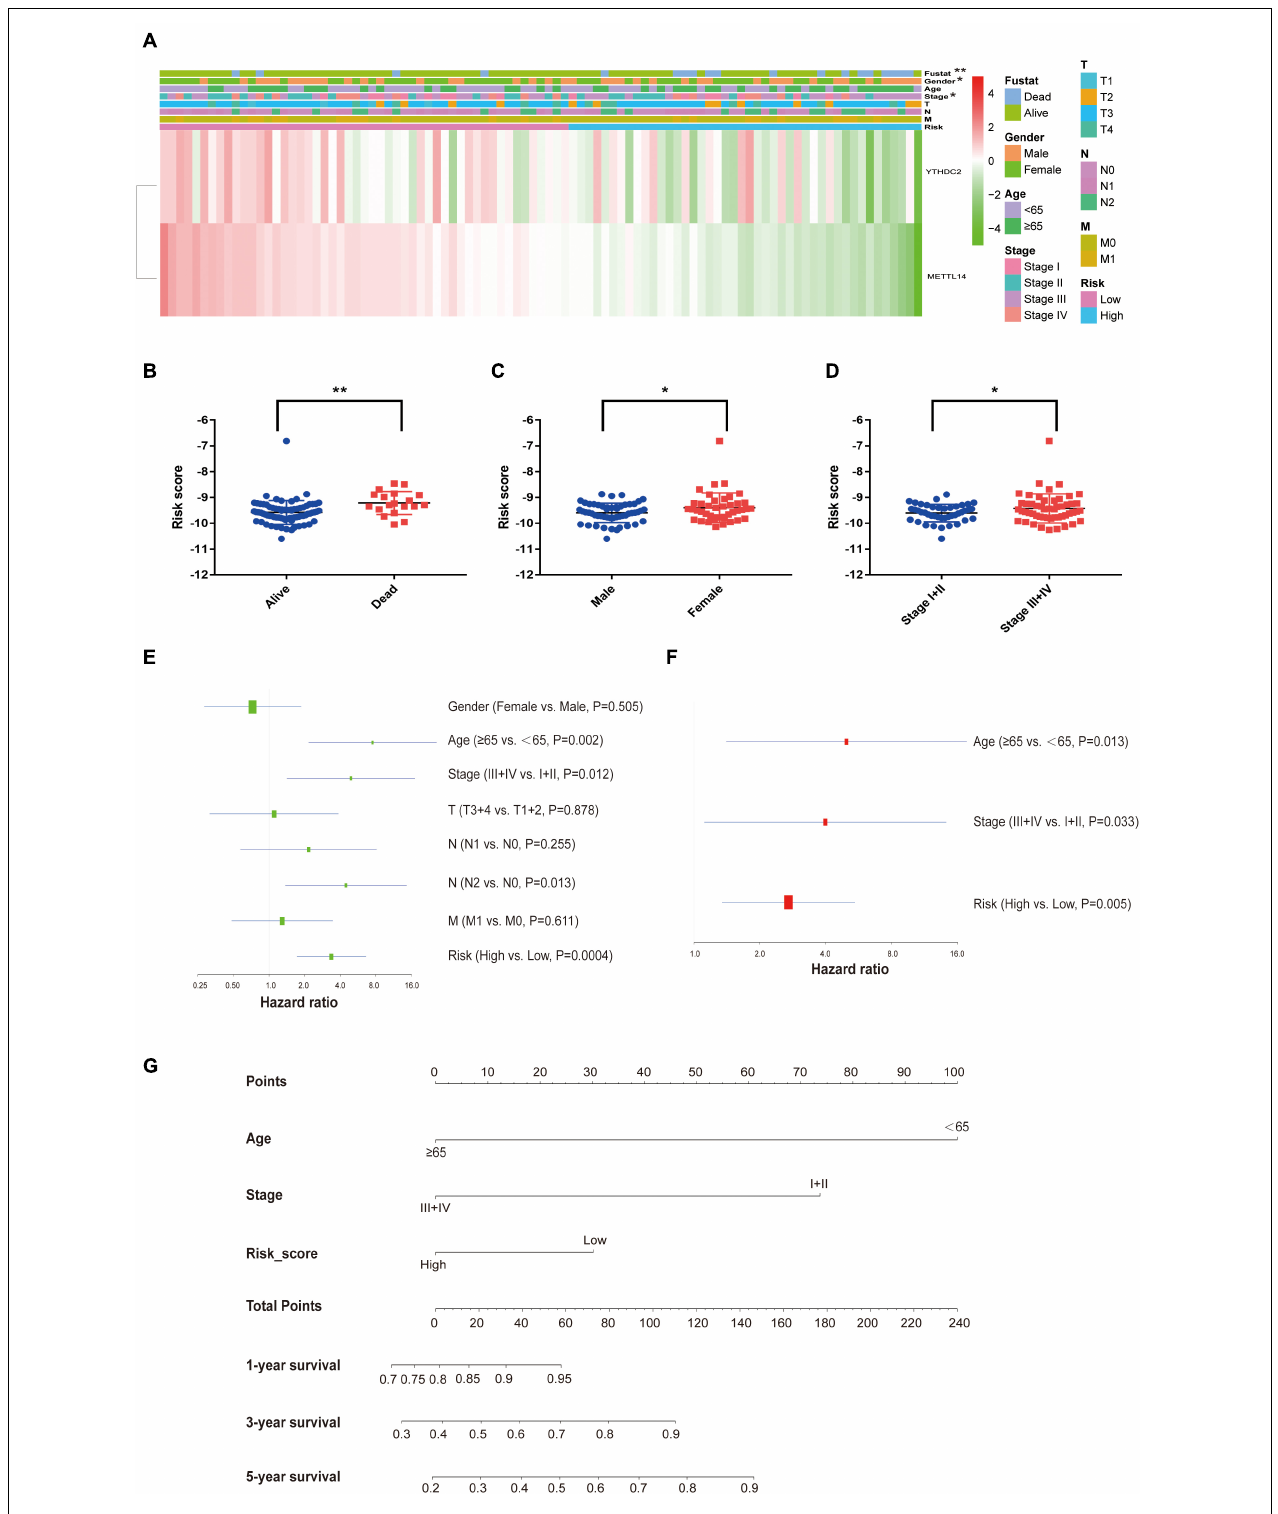
FIGURE 2 | Relation between the risk score and clinicopathological characteristics in rectal cancer. (A) The heatmap shows the expression of the two m 6 A regulator genes in the high-risk and low-risk rectal cancer. (B–D) The distribution of risk score in patients stratified by the live status (B) , gender (C) , and pathological stage (D) (unpaired T-tests). (E,F) The forest plot of univariate and multivariate Cox regression analysis. (G) The nomogram integrating risk score and clinicopathological factors in the prediction model. * P < 0.05, ** P < 0.01.